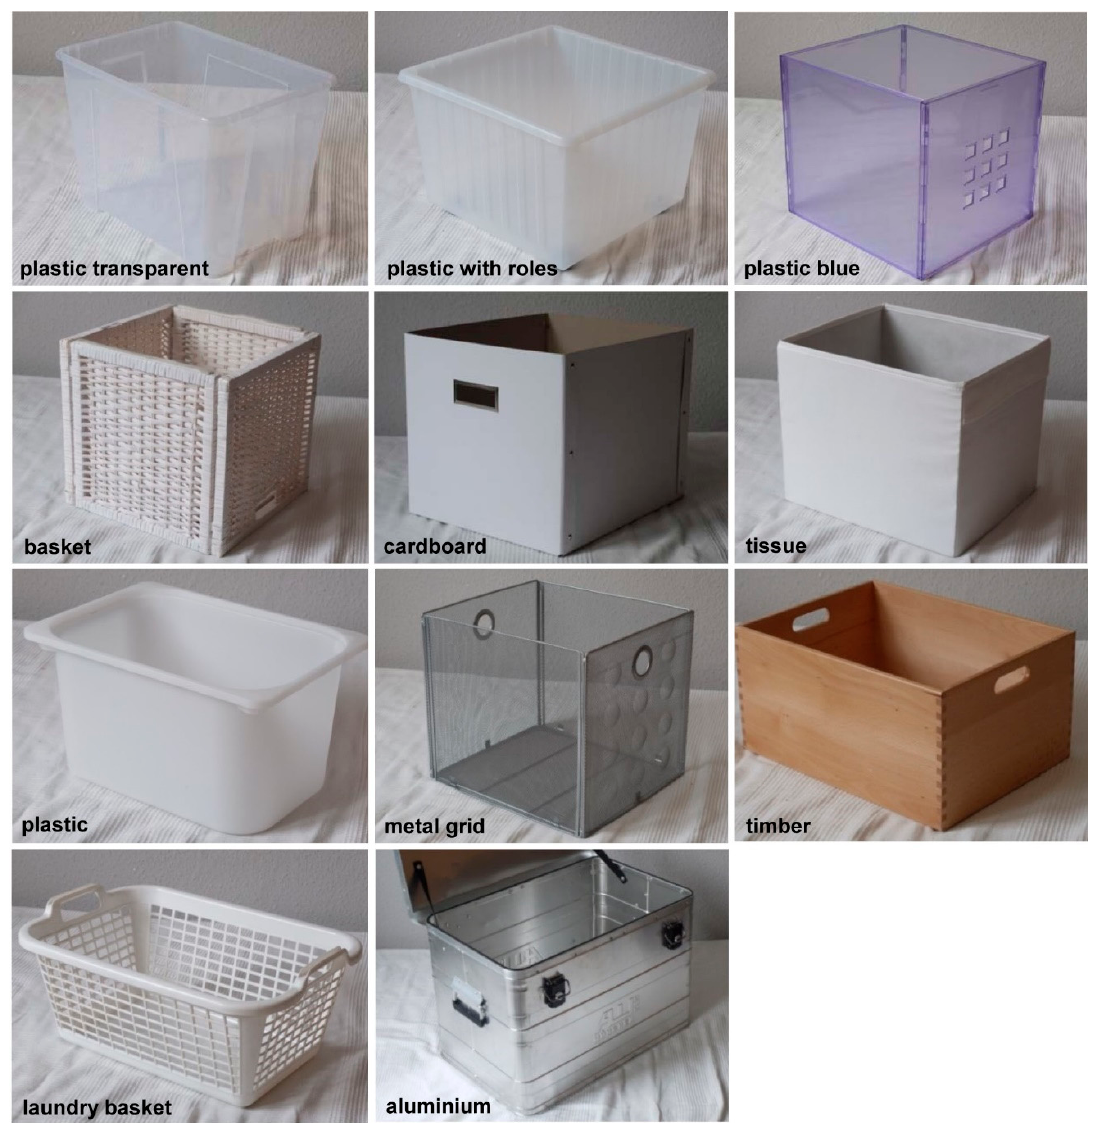
Figure 2. Storage cases of different materials and designs investigated by sound analyses.